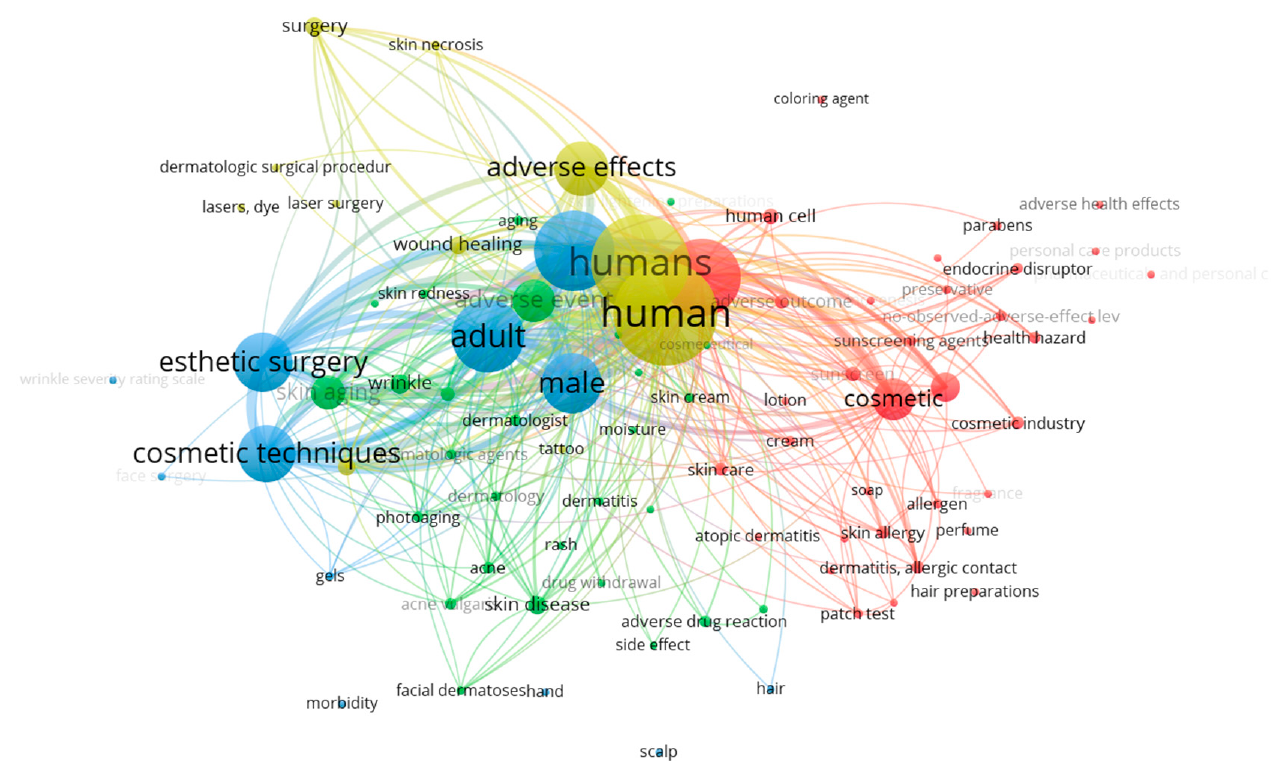
Figure 2. Keyword network of cosmetic adverse effects literature.